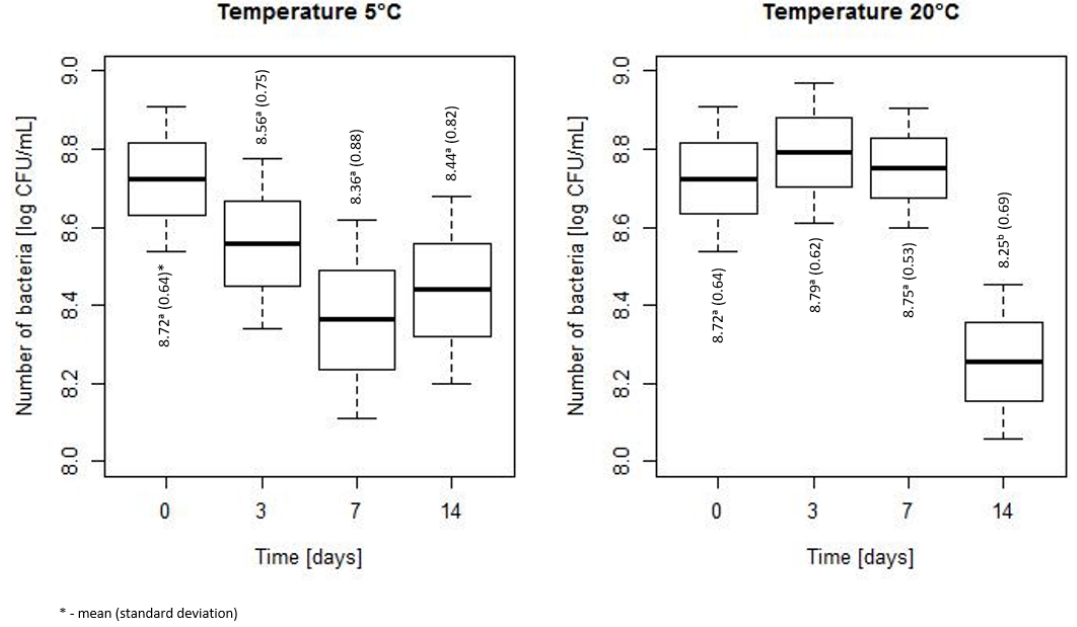
Figure 3. The changes of the bacteria number during storage at 5 and 20 °C (the horizontal line is the mean, the box spans represent standard error and the whiskers represent 95% confidence interval).